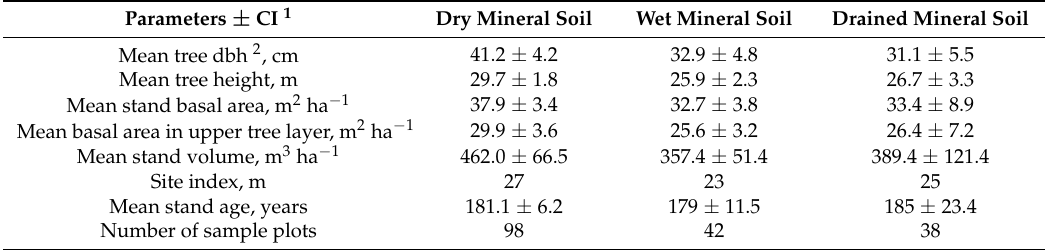
Table 1. Characteristics of over-mature spruce stands of each forest site type. The forest site types included dry ( Hylocomniosa , Oxalidosa ), wet ( Myrtilloso-sphagnosa , Myrtilloso-polytrichosa ), and drained ( Myrtillosa mel .) mineral